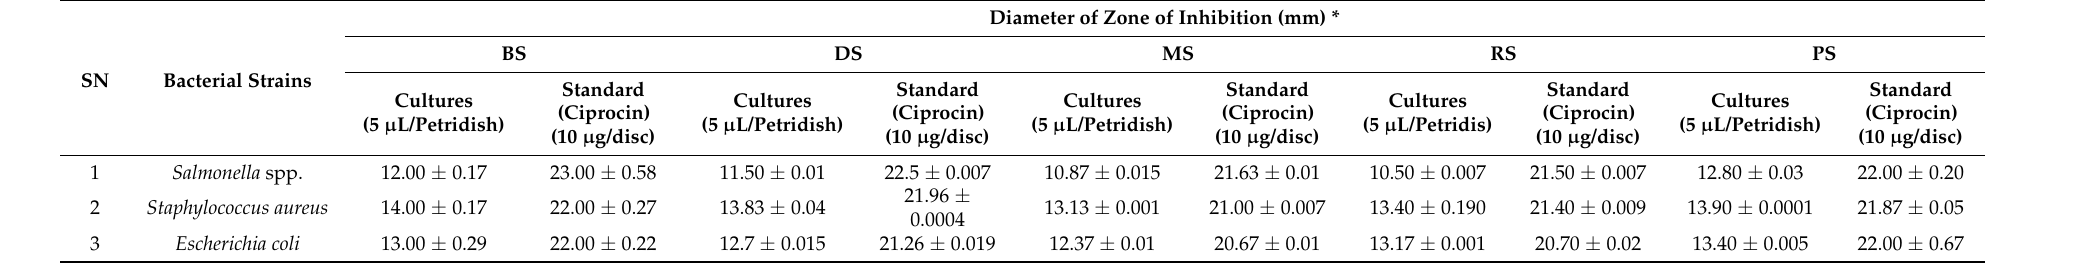
Table 3. Antibacterial activity of hog plum ( Spondias mombin L.) peel oil extracted from different regions of Bangladesh.